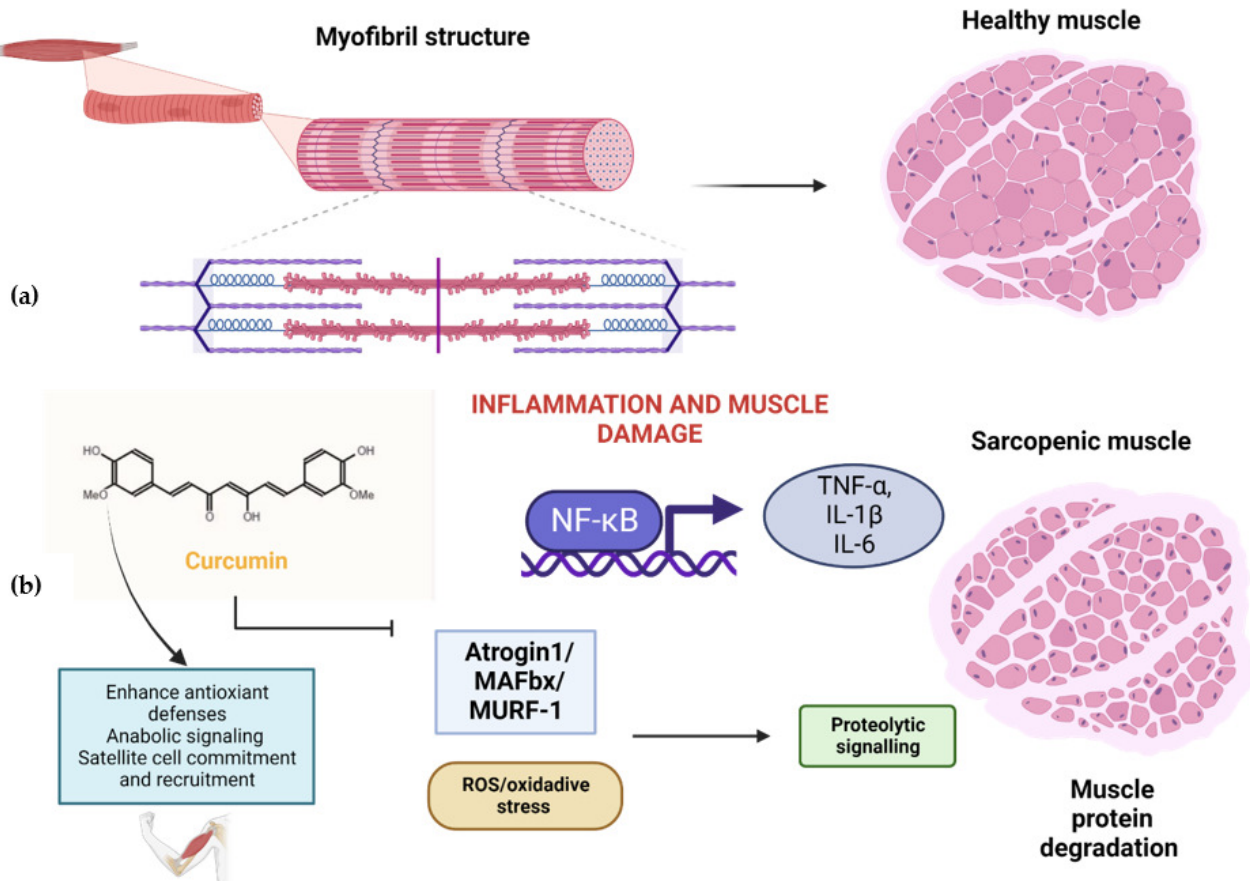
Figure 3. ( a ) Myofibril structure in healthy muscles. ( b ) Effects of curcumin on human skeletal muscle. Curcumin inhibits inflammation and muscle damage by hampering NF-kB and the proinflammatory interleukins TNF-α, IL-1β, and IL-6, as well as the proteasome complex system for protein muscle degradation integrated by ubiquitin ligases atrogin 1, muscle atrophy F-box (MAFbx), and muscle RING finger-1 (MUFR-1). Curcumin reduces oxidative-stress-enhancing antioxidant cell defenses and promotes anabolic signaling, myofibril integrity, mitochondrial function, and satellite cell commitment and recruitment for muscle repair. Created with BioRen- der.com.